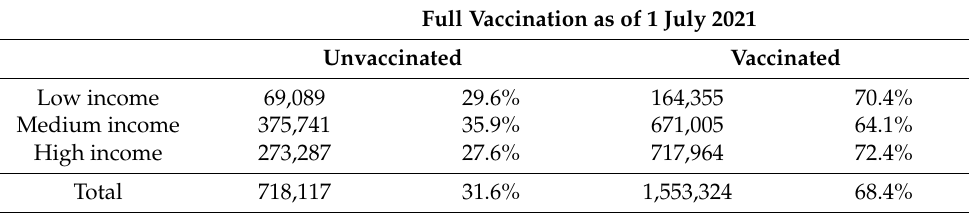
Table 2. Distribution of vaccination by socioeconomic level and